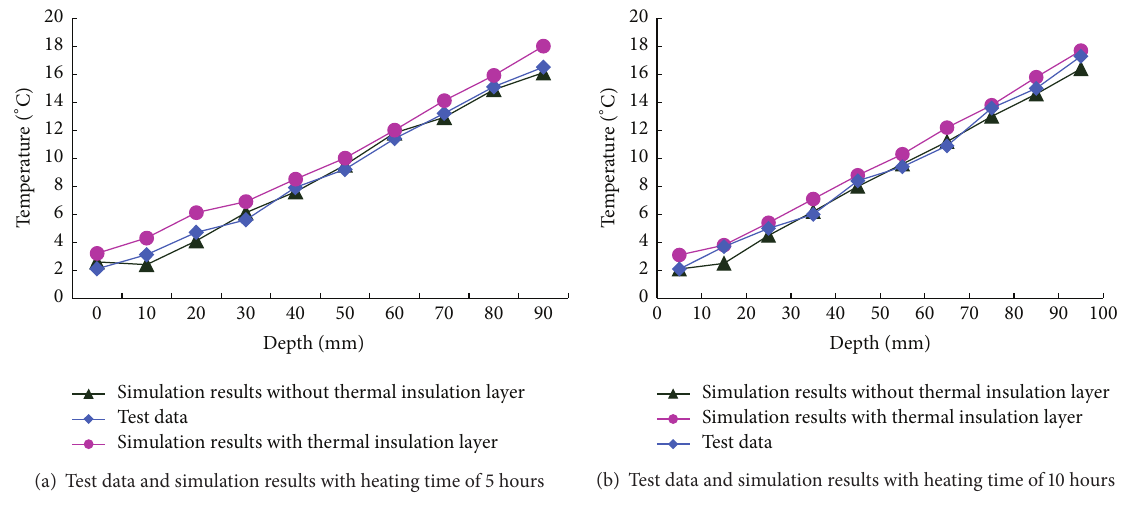
Figure 18: Comparison of the simulation results and test